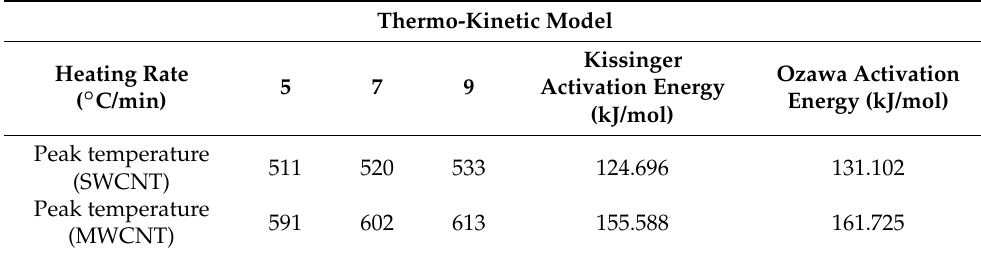
Table 1. Activation energy calculations for SWCNT and MWCNT.